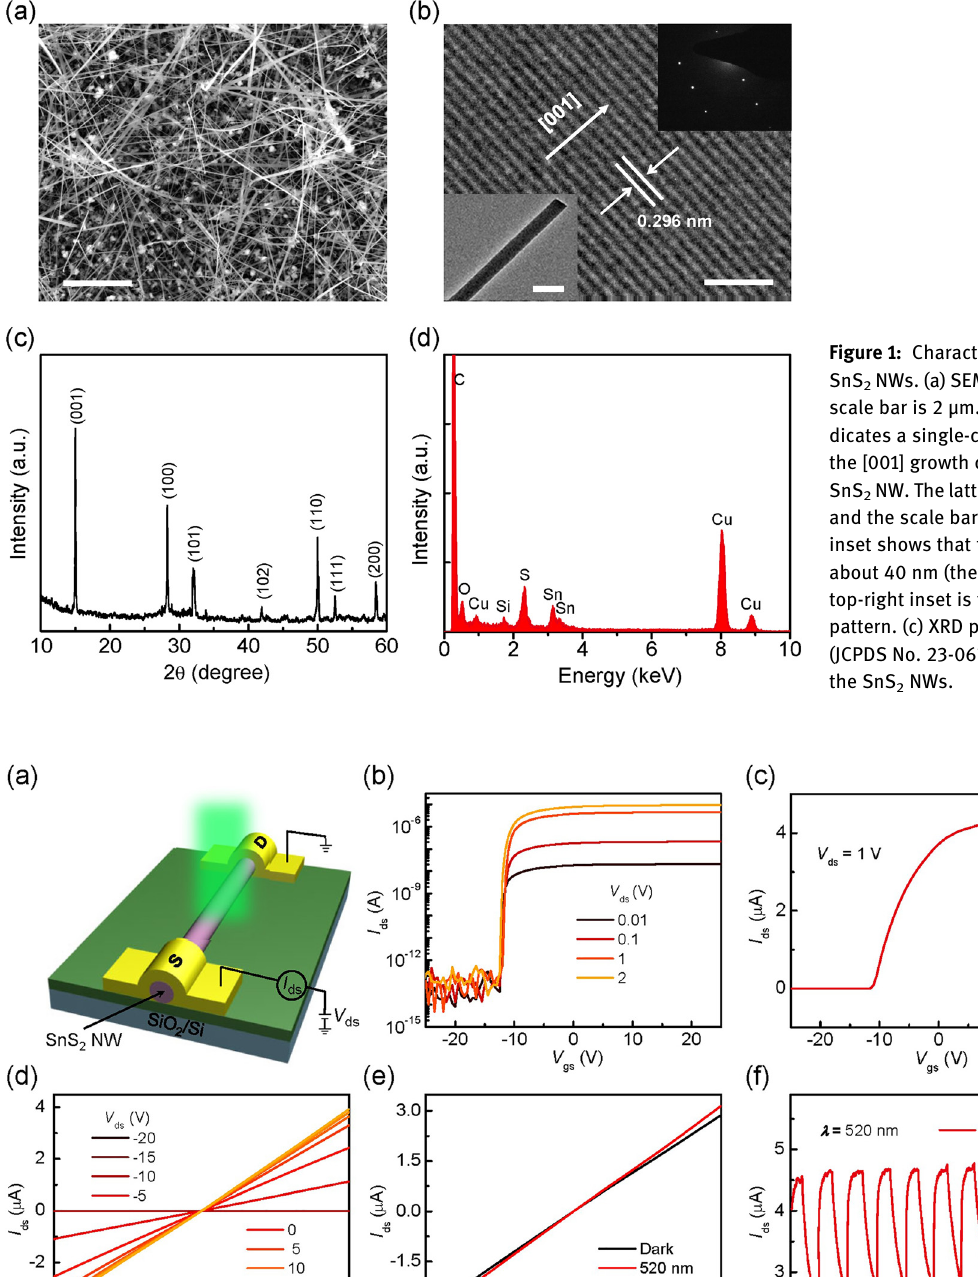
Figure 2: Electrical and optoelectronic properties of the single SnS 2 NW back-gated FET. (a) Schematic diagram of the single SnS 2 NW back- gated FET photodetector. (b) I ds – V gs transfer characteristics of the SnS 2 NW FET at different bias voltages V ds . (c) Linear plot of I ds – V gs transfer characteristics at V ds = 1 V. (d) I ds – V ds output characteristics of the device, the back-gated voltage interval is 5 V. (e) I ds – V ds output characteristics of the device in dark and under the illumination of 520 nm laser, measured without additional back-gated voltage. (f) Photocurrent response of the device under optical chopping at V ds = 1 V without additional back-gated voltage (520 nm, 11 mW cm − 2 ).